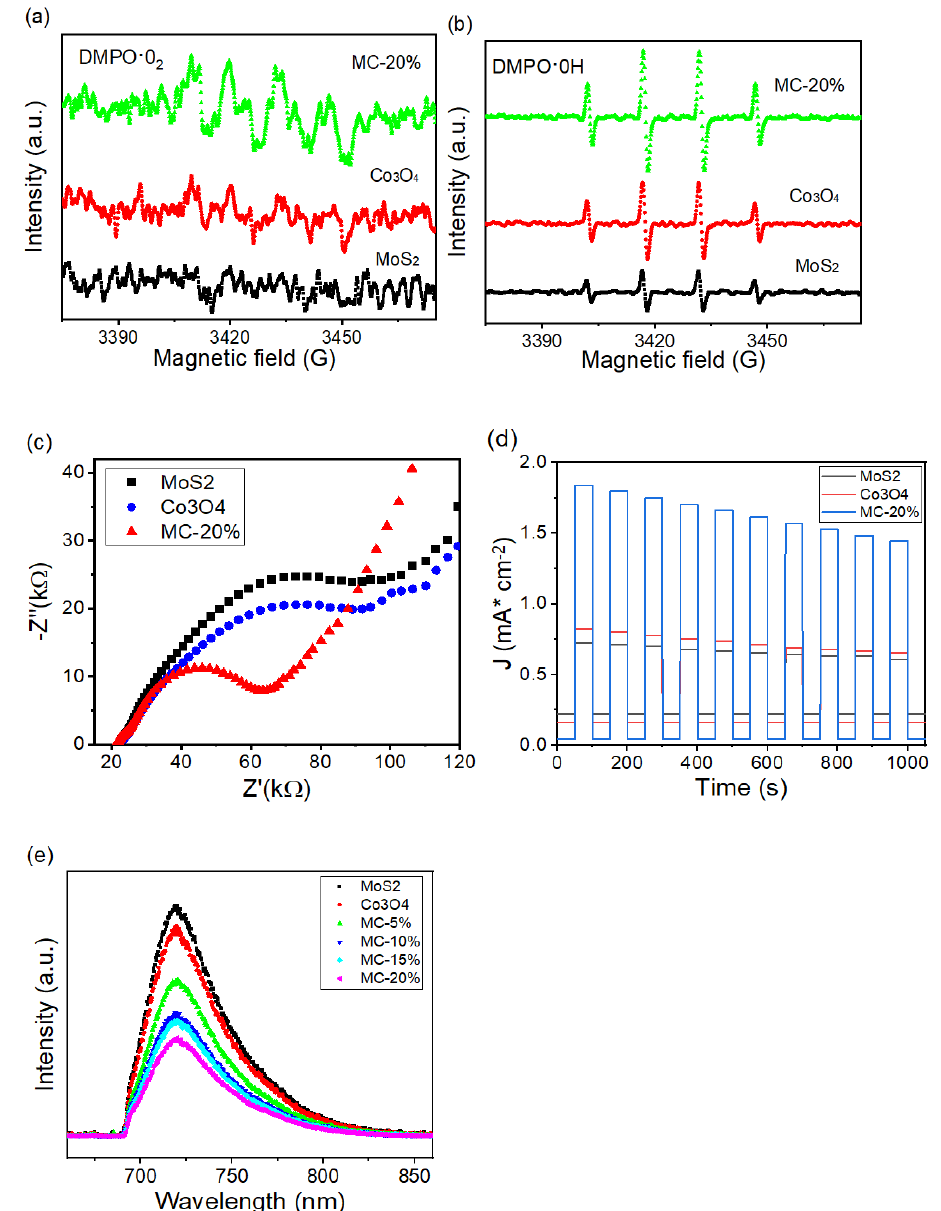
Figure 6. DMPO spin − trapping ESR spectra for ( a ) • O 2 − and ( b ) • OH with visible light for MoS 2 , Co 3 O 4 and MC − 20%, ( c ) Electrochemical impedance spectra (EIS) of MoS 2 , Co 3 O 4 , and MoS 2 /Co 3 O 4 in 0.5 M Na 2 SO 4 solution with visible light activity, and ( d ) Transient photocurrent densities of MoS 2 , Co 3 O 4 , and MoS 2 /Co 3 O 4 electrodes in 0.5 M Na 2 SO 4 solution with visible light, ( e ) PL spectra under the excitation wavelength of 580 nm of MoS 2 , Co 3 O 4 , MC − 5%, MC − 10%, MC − 15% and MC − 20%.